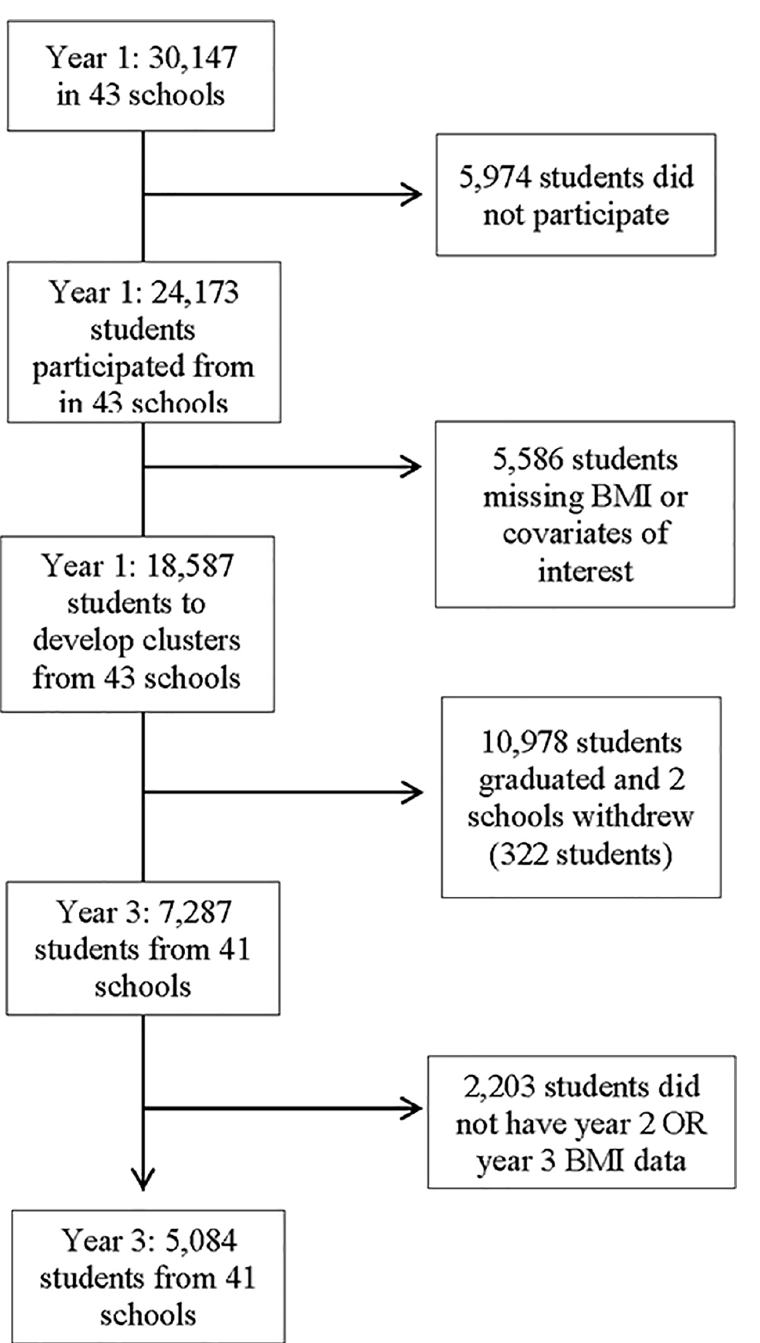
Fig 1. Flowchart of participating students and